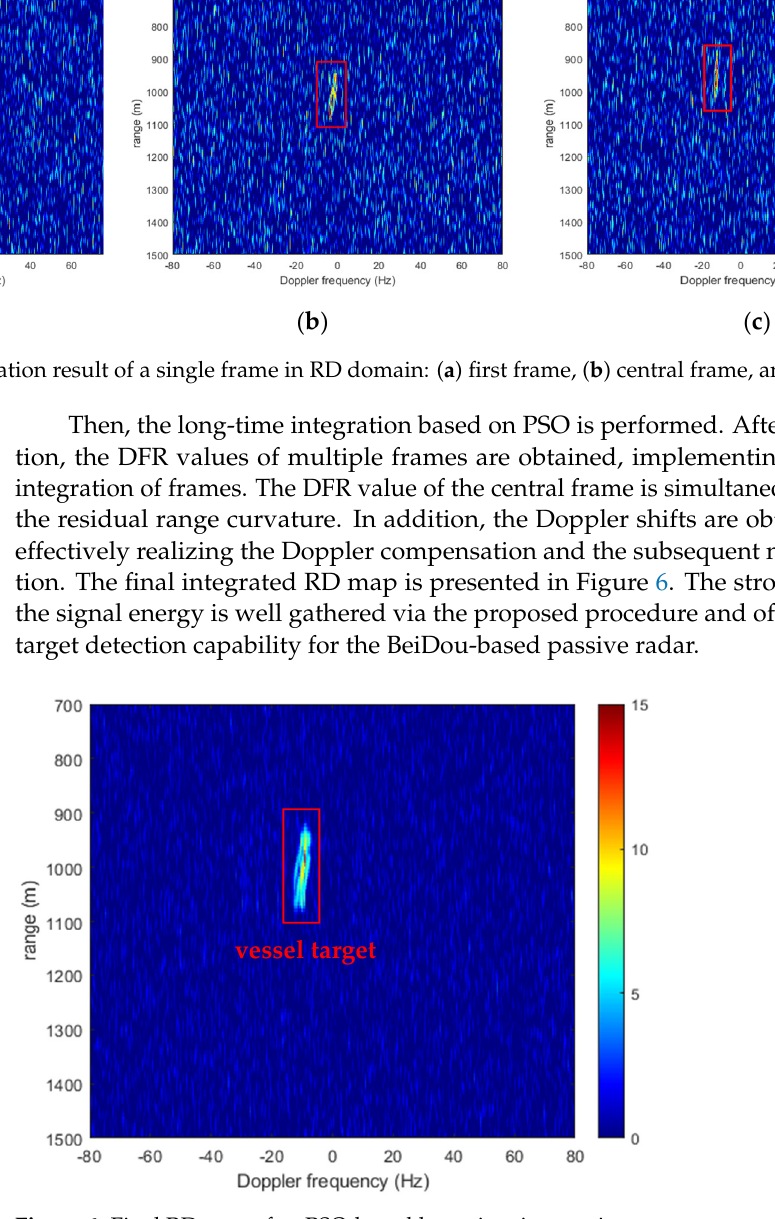
Figure 6. Final RD map after PSO-based long-time integration.